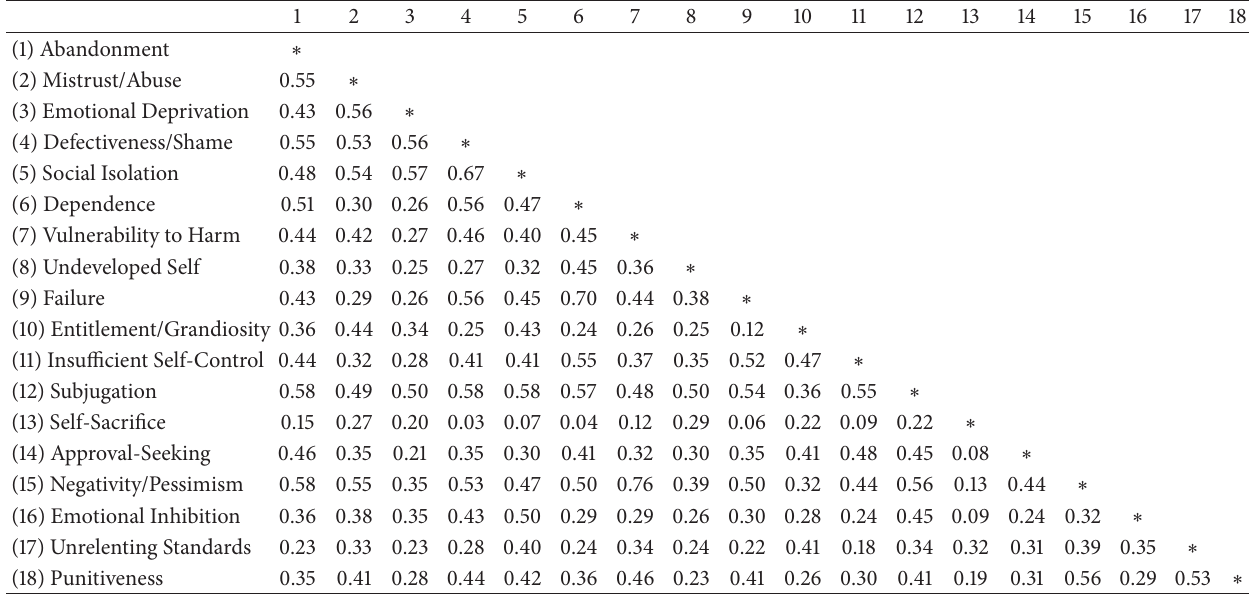
Table 3: Intercorrelations between EMSs.